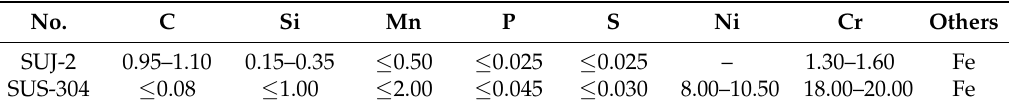
Table 1. Composition of steel (SUJ-2) and stainless steel (SUS-304) balls in the work.